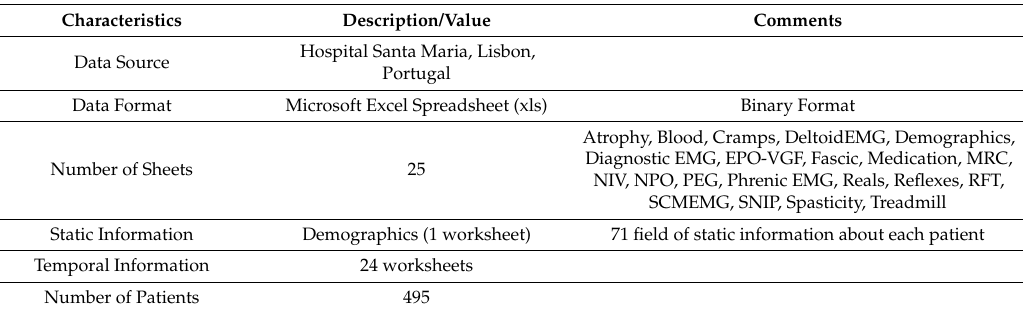
Table 4. Dataset description.